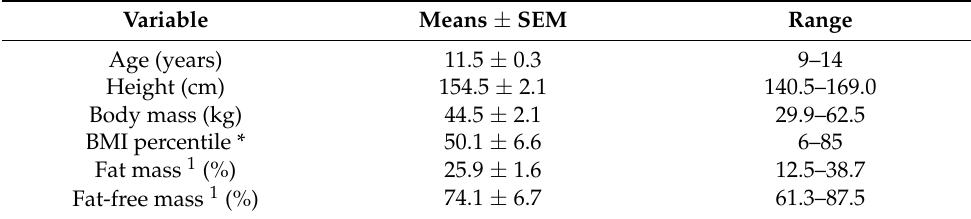
Table 1. Baseline Characteristics ( n = 17; 8 boys, 9